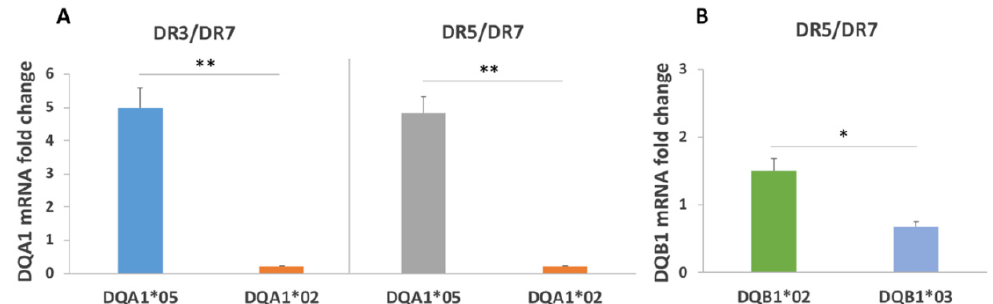
Figure 2. Expression of DQA1 and DQB1 genes. ( A ) The DQA1*05 mRNA shows a 25-fold variation in respect to DQA1*02 mRNA in DR3/DR7 M Φ ( n = 4: CD20, CD25, CD31, and CD35) and a 24-fold variation in the DR5/DR7 genotype. ( n = 2: CD26 and CD34). ( B ) DQB1*02 mRNA is also more abundant than the DQB1*03 mRNA in M Φ with the DR5/DR7 genotype ( n = 2: CD26 and CD34). (* p < 0.05, ** p < 0.01).